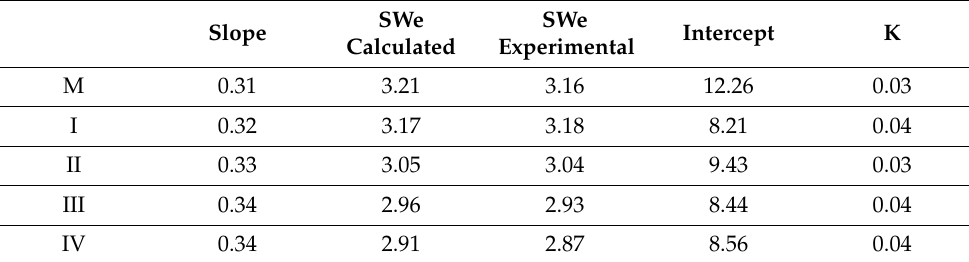
Table 2. Calculated and experimental values for swelling degree (SW e ) and for rate constant (K) based on Schott’s equation. SWe SWe Intercept K Slope Calculated Experimental M